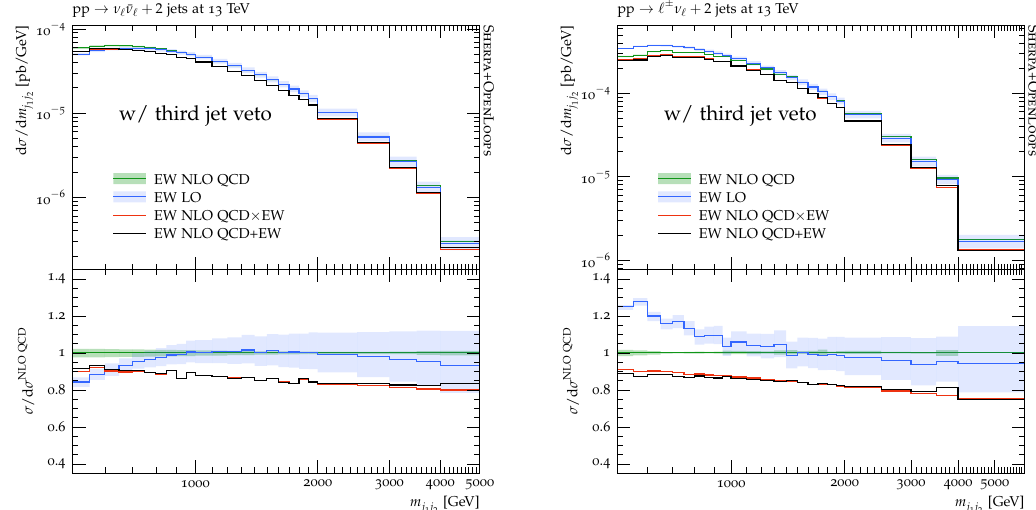
Figure 9. Distribution in the invariant mass of the two hardest jets, m j Z ( ν ‘ ¯ ν ‘ ) + 2 jets (left) and EW pp → W ± ( ‘ ± ν ‘ ) + 2 jets (right) subject to the dynamic third jet veto of eq. (3.12). Curves and bands as in figure